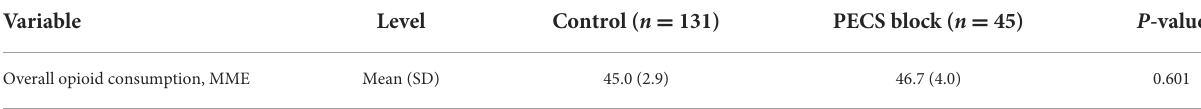
TABLE 4 Logistic regression analysis of overall opioid consumption adjusted by surgery length or surgery type. Variable